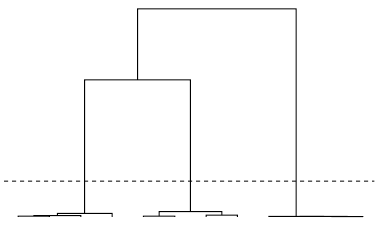
Figure 3. Four partitions dendrogram for the ellipses